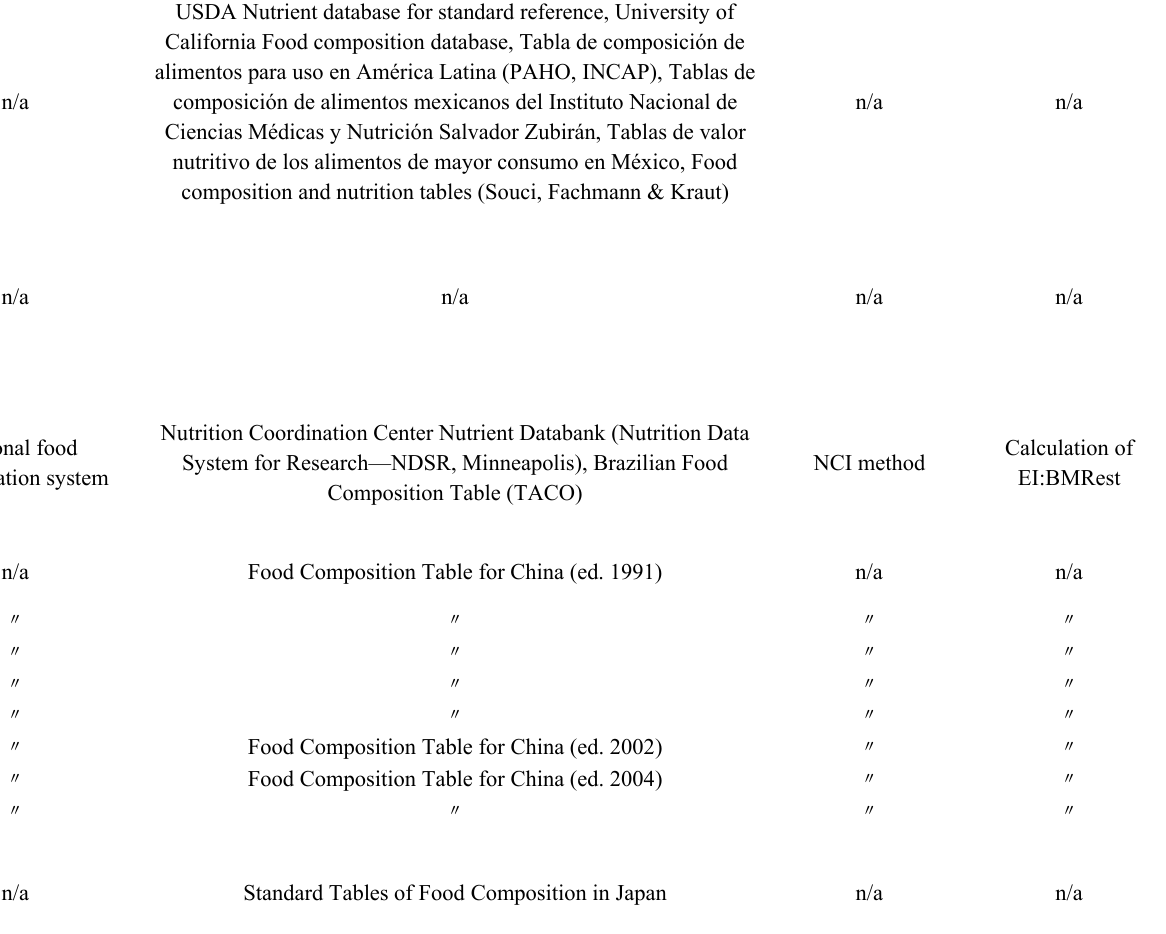
Food Composition Table for China (ed. 1991)